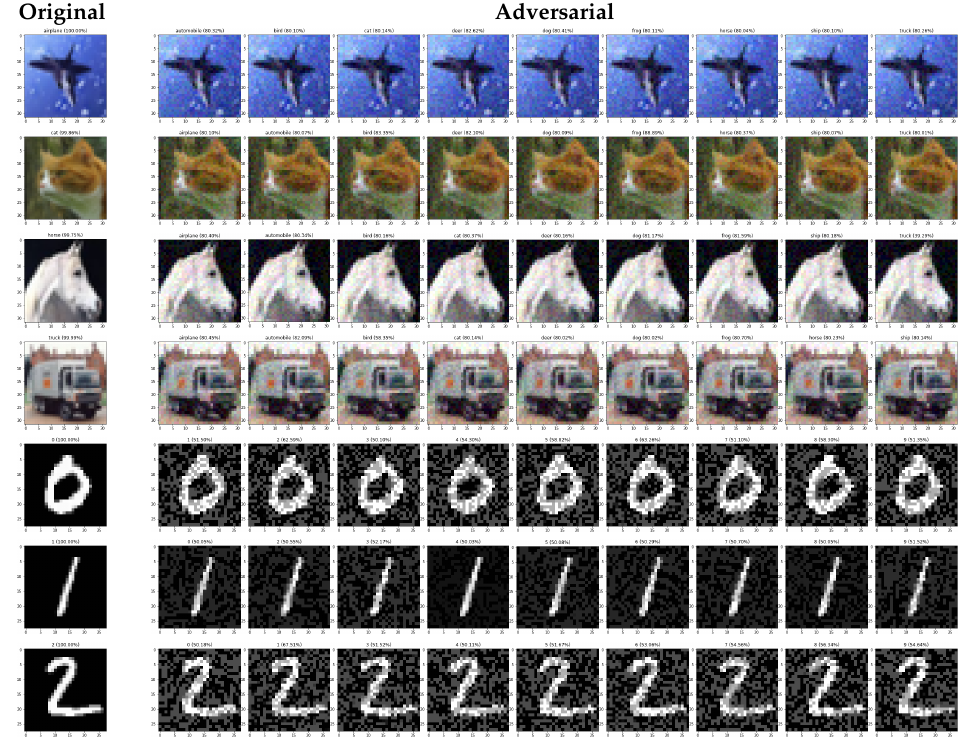
Figure 3. Our adversarial examples on CIFAR-10 and MNIST datasets: The leftmost column is original images. The next 9 columns show examples of targeted attacks against nine classes other than the original image class without undergoing perturbation pruning.